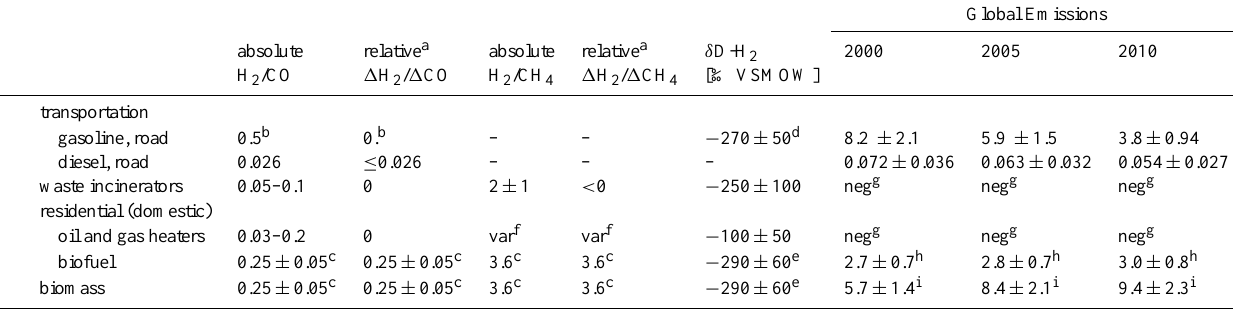
Table 3. Molar [ppm/ppm] ratios of molecular hydrogen (H 2 ) to carbon monoxide (CO), to methane (CH 4 ), and isotopic signatures ( δ D-H 2 ) for selected combustion processes. Global H 2 emissions (in Tg) are given for 2000, 2005, and